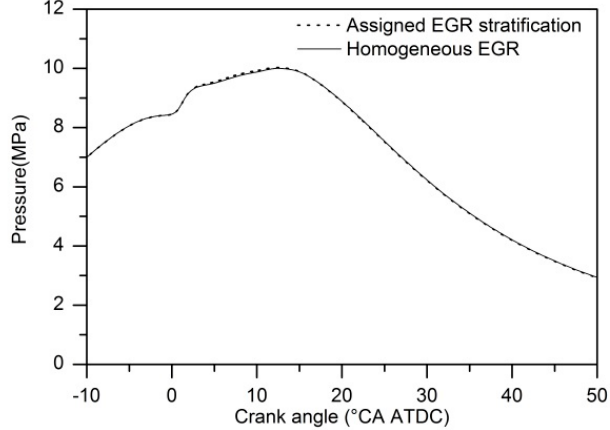
Figure 6. Comparison of in-cylinder pressure between uniform EGR and assigned EGR stratification with equal mass of EGR in cylinder.